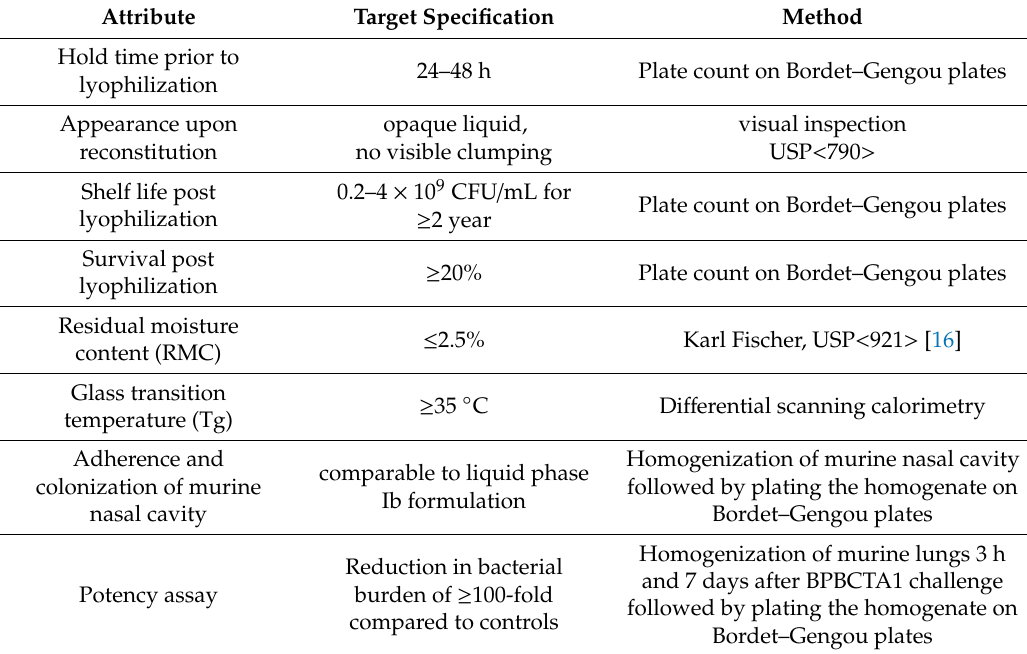
Table 2. Target drug product attributes for the lyophilized BPZE1 drug product.